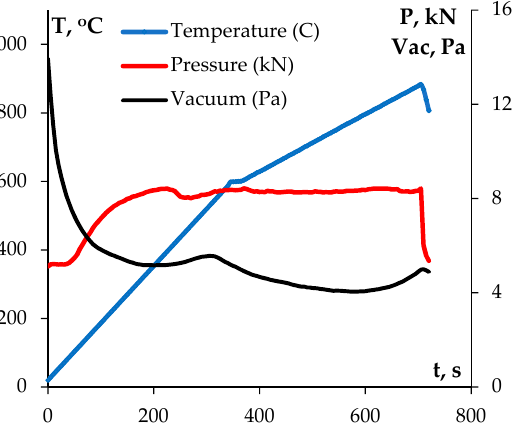
Figure 7. Dependences of temperature (T), applied pressure (P), and vacuum pressure (Vac) on SPS time for Na 1.2 Zr 1.9 Co 0.1 (PO 4 ) 3 ceramics.